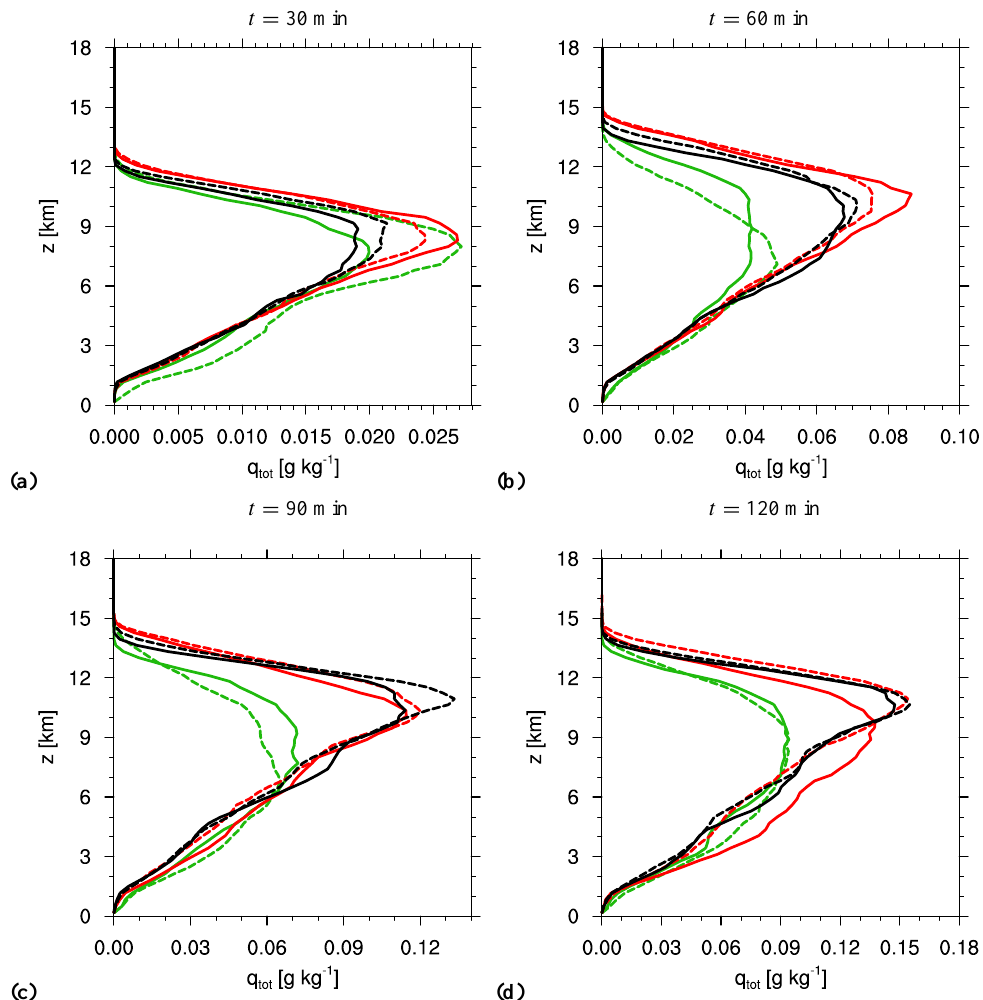
Fig. 4. Conditionally-averaged total condensate mixing ratios ( q tot ) at 30min (a) , 60min (b) , 90min (c) , and 120min (d) are depicted for the bin (green), bulk-explicit (black), and bulk-original (red) model configurations. Here, the sum of q tot at each level for all points in which w ≥ 2ms − 1 is computed and divided by the horizontal domain size to calculate the conditional average. Shown here are the “Clean” (solid) and “Polluted” (dashed) aerosol scenarios. Note that the x -axes are different so as to clearly represent the change in q tot between aerosol scenarios and not to distinguish between the changes in q tot between different